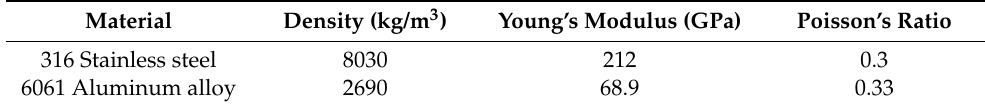
Table 1. Material properties of particles and walls.